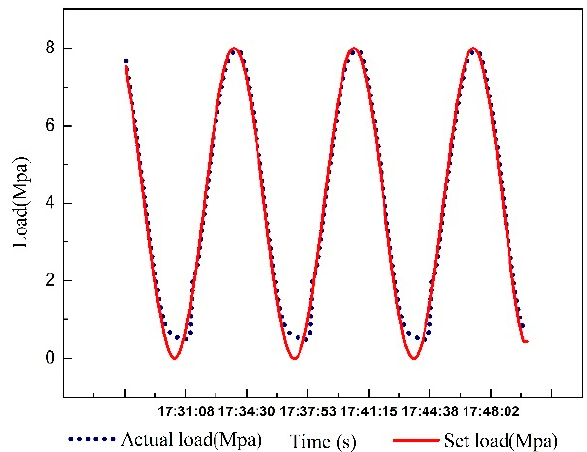
Figure 13. Dynamic curve diagram of real time data.